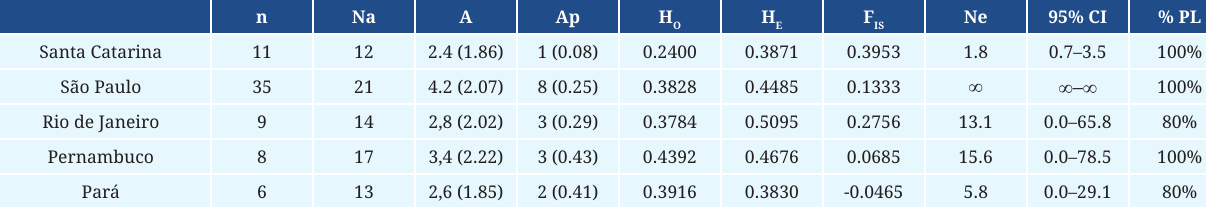
TABLE 1 | Genetic diversity indices of the five microsatellite loci for Rhinoptera bonasus. n: number of individuals analyzed, Na: number of alleles. A: number of alleles per locus and Ap: number of private alleles, in parentheses is the same estimates average based on rarefaction; H : observed heterozygosity, H : expected heterozygosity, F : inbreeding coeficiente, Ne: effective population size based on the molecular O E IS coancestry method; 95% CI: Single standard deviation with 95% confidence interval, % PL: percentage of polymorphic